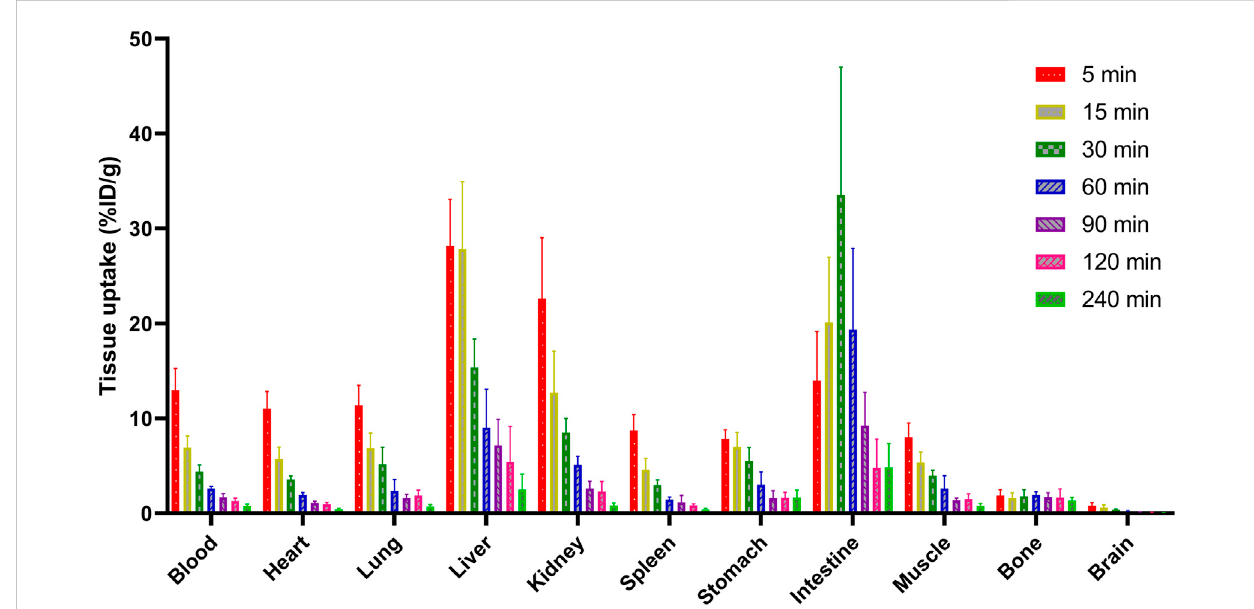
FIGURE 4 Biodistribution pro fi le of [ 18 F] 3 in normal Kunming mice.